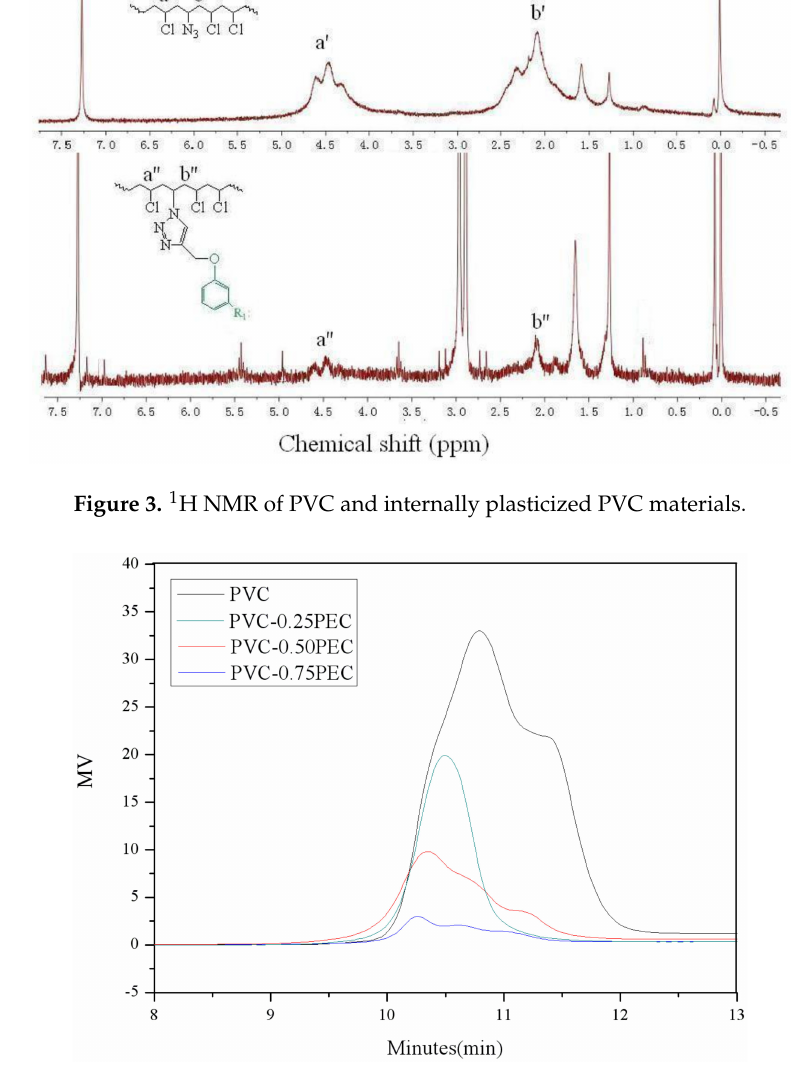
Figure 4. GPC spectra of PVC and internally plasticized PVC